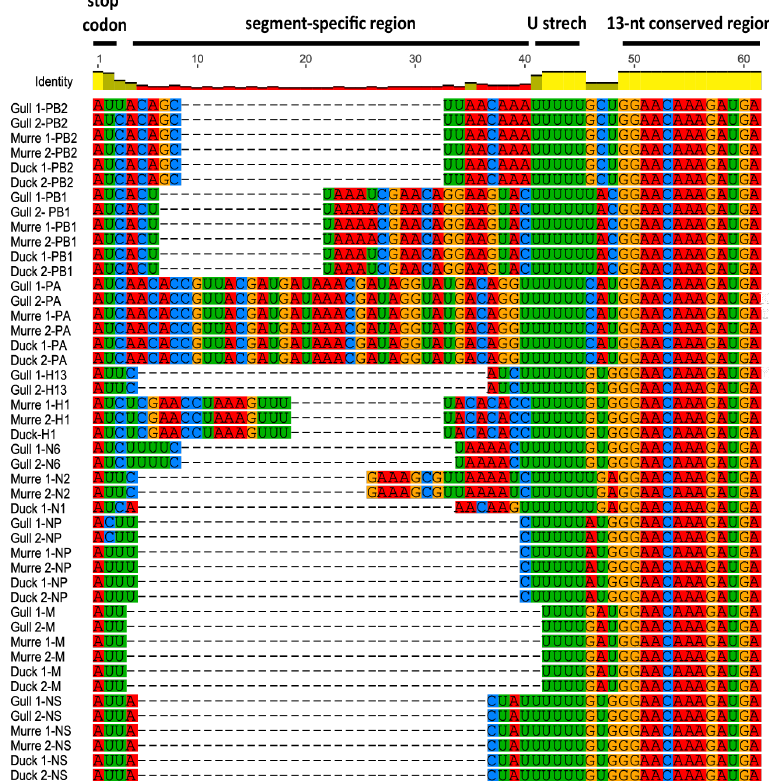
Figure 2. 5 ′ NCRs of wild bird virus segments determined in this study. The multiple alignment of 5 ′ NCRs was generated with MUSCLE implemented in Geneious version 8. The RNA sequences are displayed in the 3 ′ to 5 ′ orientation corresponding to the packaged RNAs.